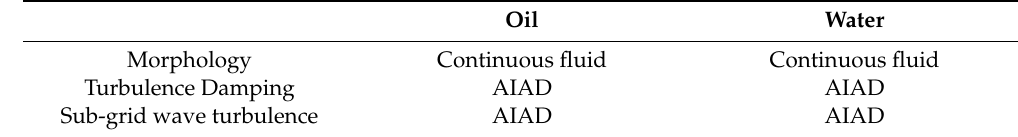
Table 5. Fluid modelling